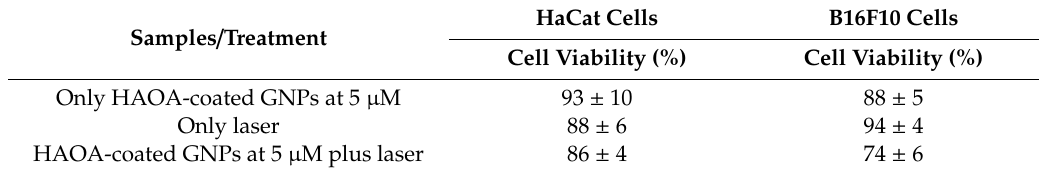
Table 3. Preliminary assays towards melanoma cells using phototherapy where the laser irradiation tests were carried out for 3